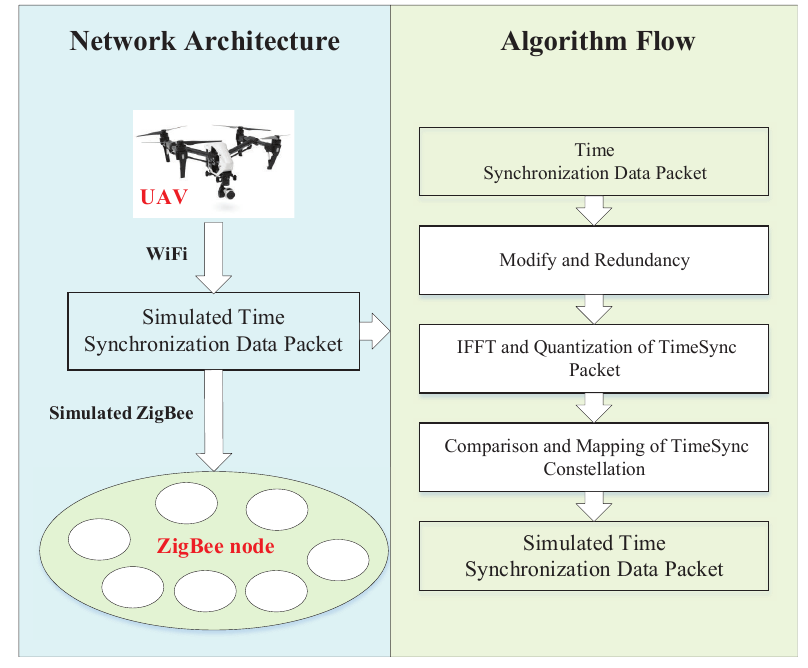
Figure 1. UAV-TS algorithm